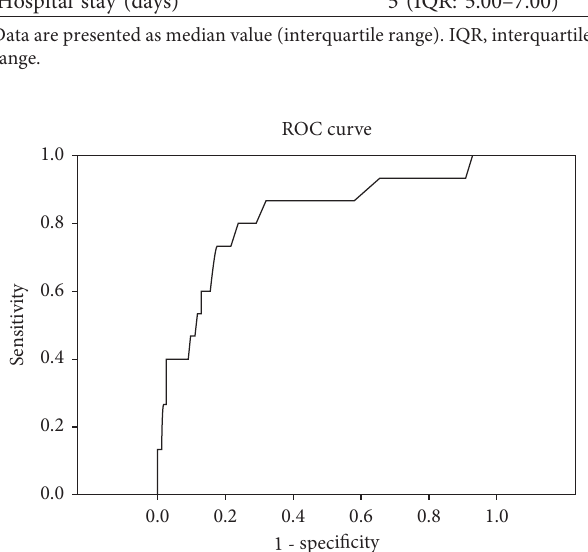
Figure 1: Receiver operating characteristic (ROC) curve analysis for RDW to identify